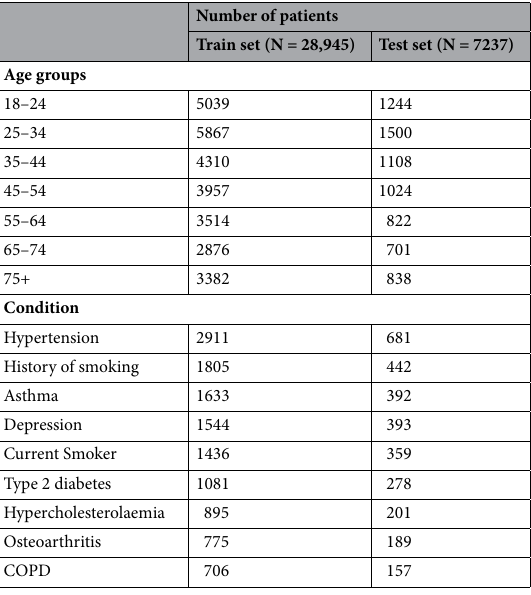
Table 2. Breakdown of patient age and most frequently occurring conditions in the training and test sets. Conditions were extracted from their ICD10 codes. A given condition is only associated with a small fraction of attendances, but in total 40.0% of attendances resulting in discharge have at least one associated condition. Patient age and conditions are extracted from their last attendance in the respective data